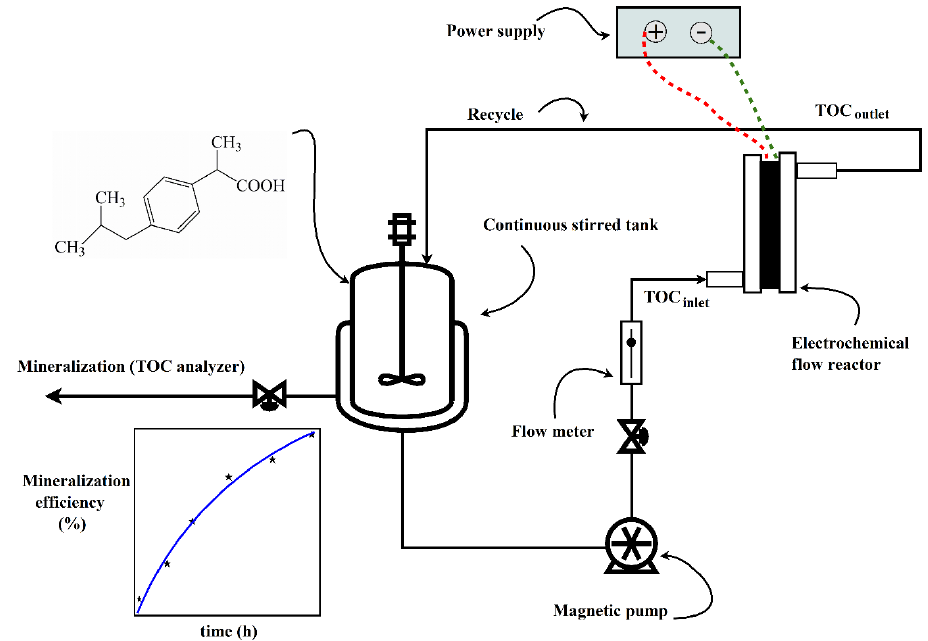
Figure 1. Experimental setup for the electrochemical mineralization of IBU in an Electrochemical Flow Reactor under recirculation batch mode.